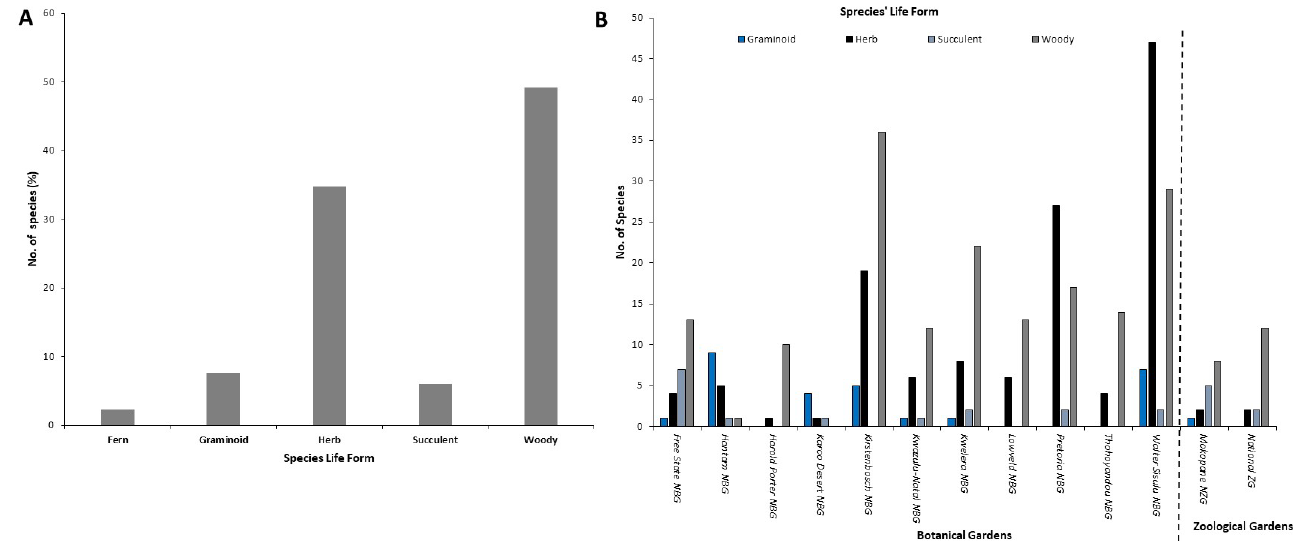
Figure 4. Number of records of different alien plant species in each life form (%; n = 380; ( A )) and their occurrence in different SANBI gardens ( B